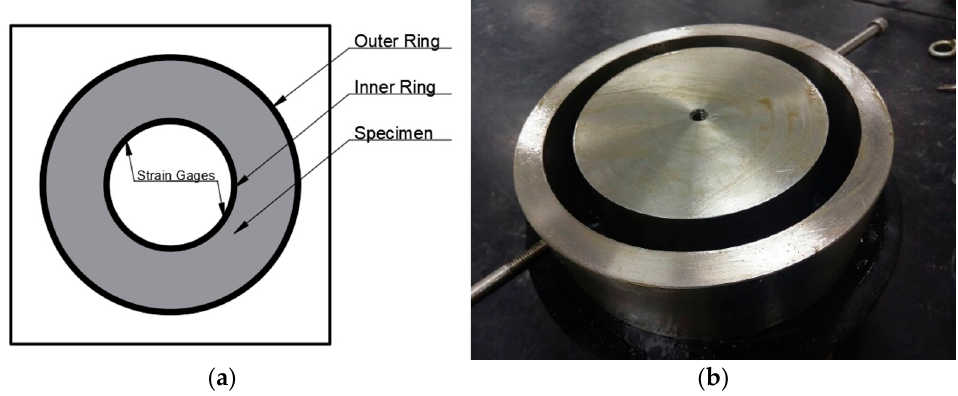
Figure 5. Schematic of the ring test model. ( a ) Model required by ASTM C1581. ( b ) Schematic of a scaled-down model of ASTM C1581.